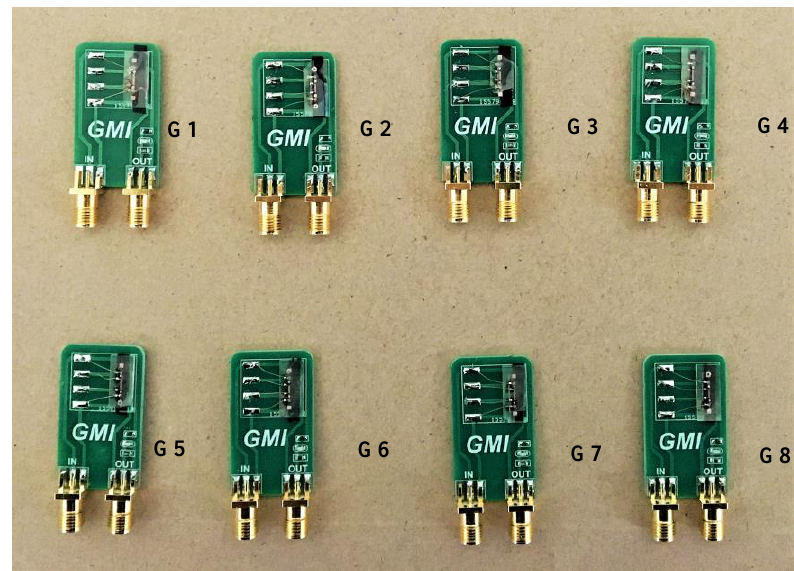
Figure 9. Eight sensors in the same batch of products were selected and numbered G1 – G8 to test the consistency of MEMS (Micro-Electro-Mechanical System) technology. Table 3. The consistence of impedance and voltage output of sensors.